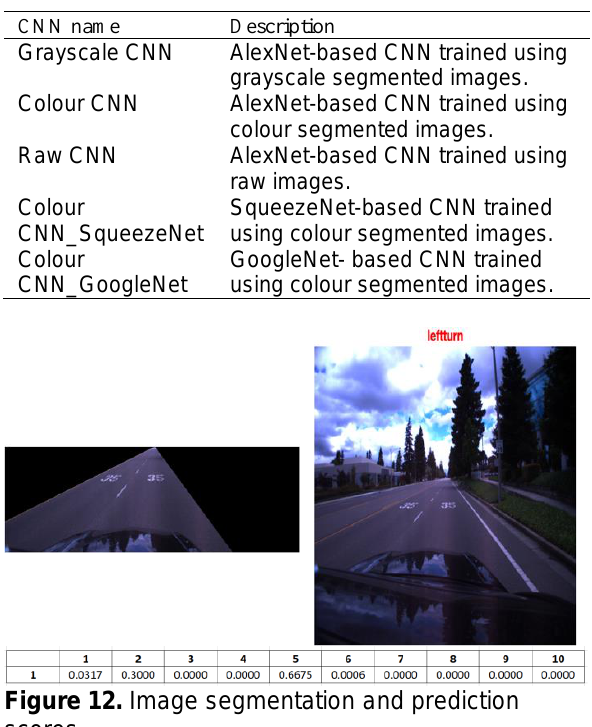
Figure 12. Image segmentation and prediction scores